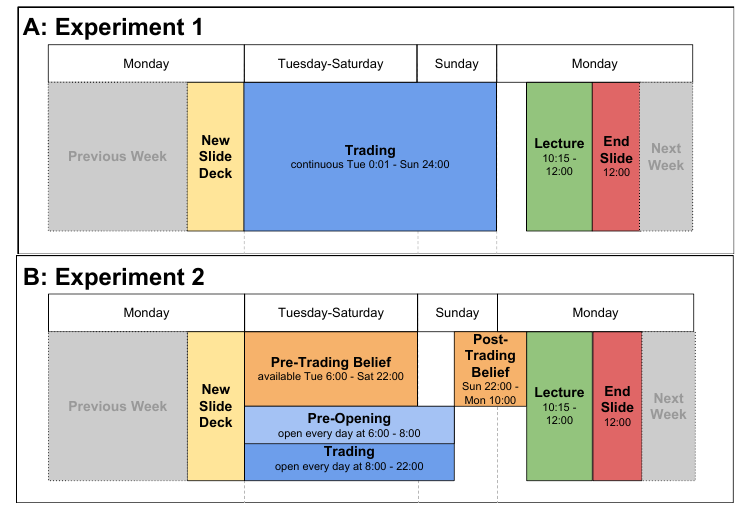
Figure 1: A: Timeline of one week of the procedure in Experiment 1. The market was continuously open from Tuesday morning until Sunday night; B: Timeline of one week of the procedure in Experiment 2. In Experiment 2, entering of the market was only possible after submitting the pre- trading belief. Participants who did not enter their pre-trading belief could not see the prices on the market. Similarly, accruing the results of one’s trading and banking on the payment of the dividend were only possible after submitting one’s post-trading